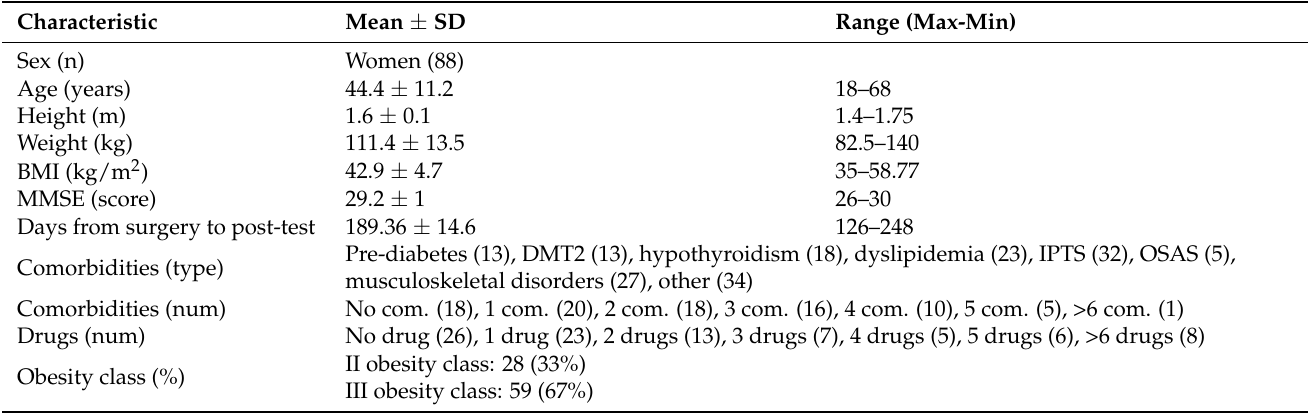
Table 1. Baseline participants’ characteristics before sleeve gastrectomy surgery (mean ± standard de-